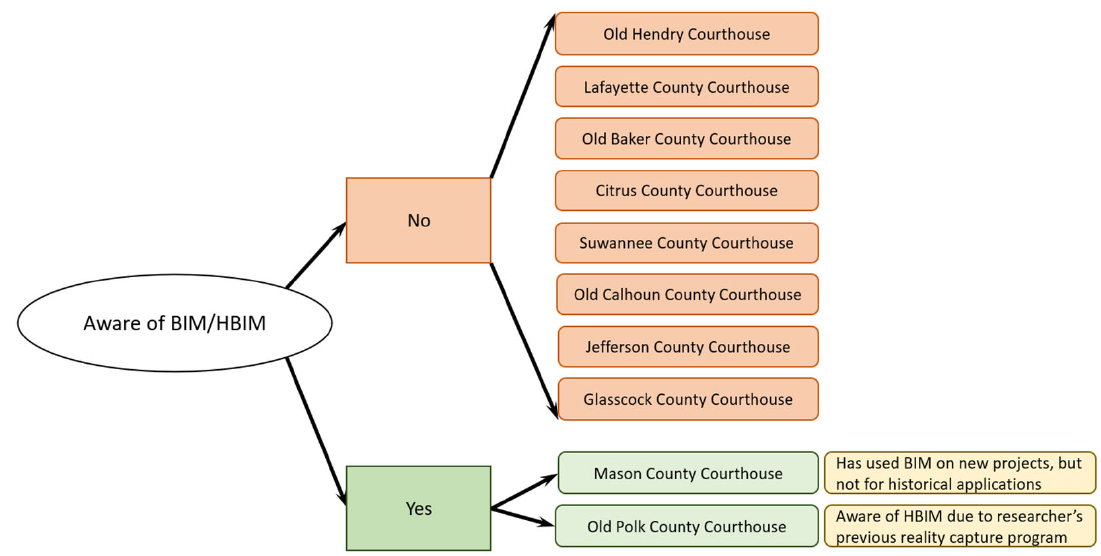
Figure 15. Results to interview question #5: awareness of BIM/HBIM.